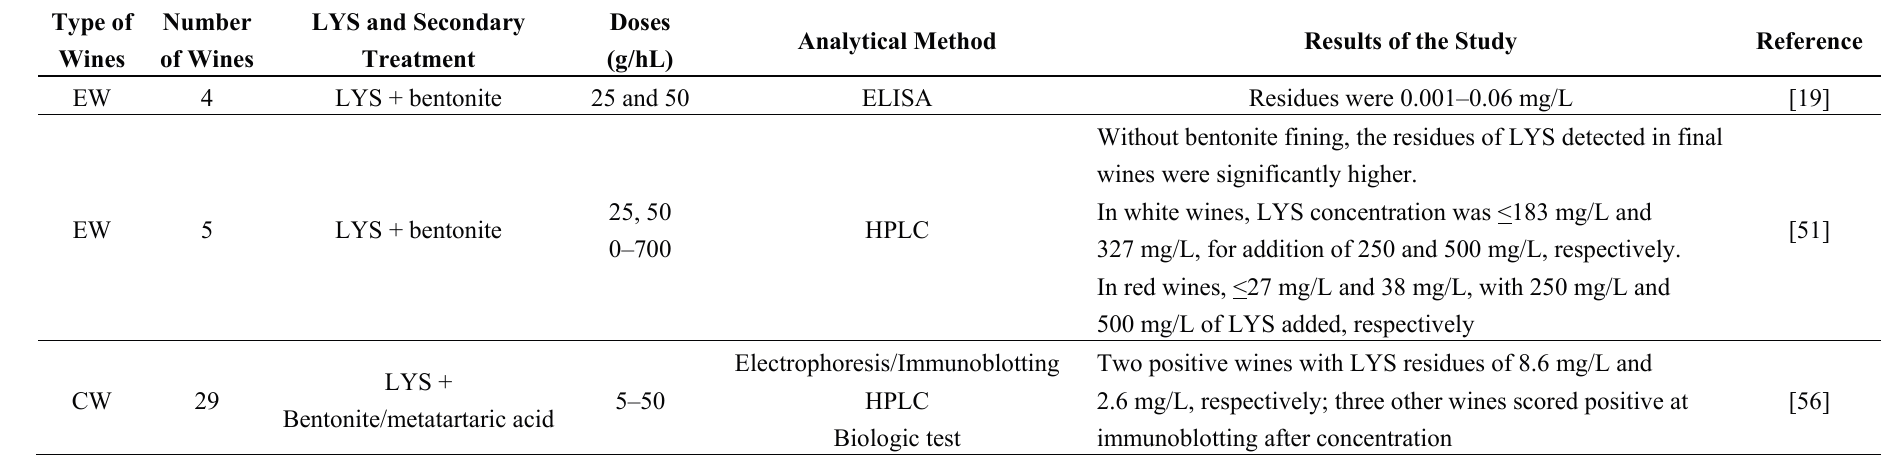
Table 7 . Studies reporting data on allergenic residues in wines to which lysozyme has been